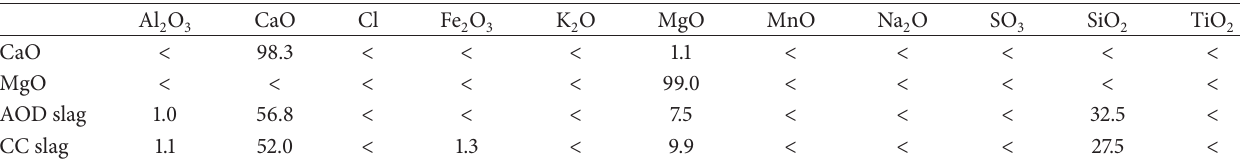
Table 1: Chemical composition (expressed as wt% oxides) of alkaline materials determined by XRF (normalized to 100wt% total; ≥ 1.0 wt% shown).